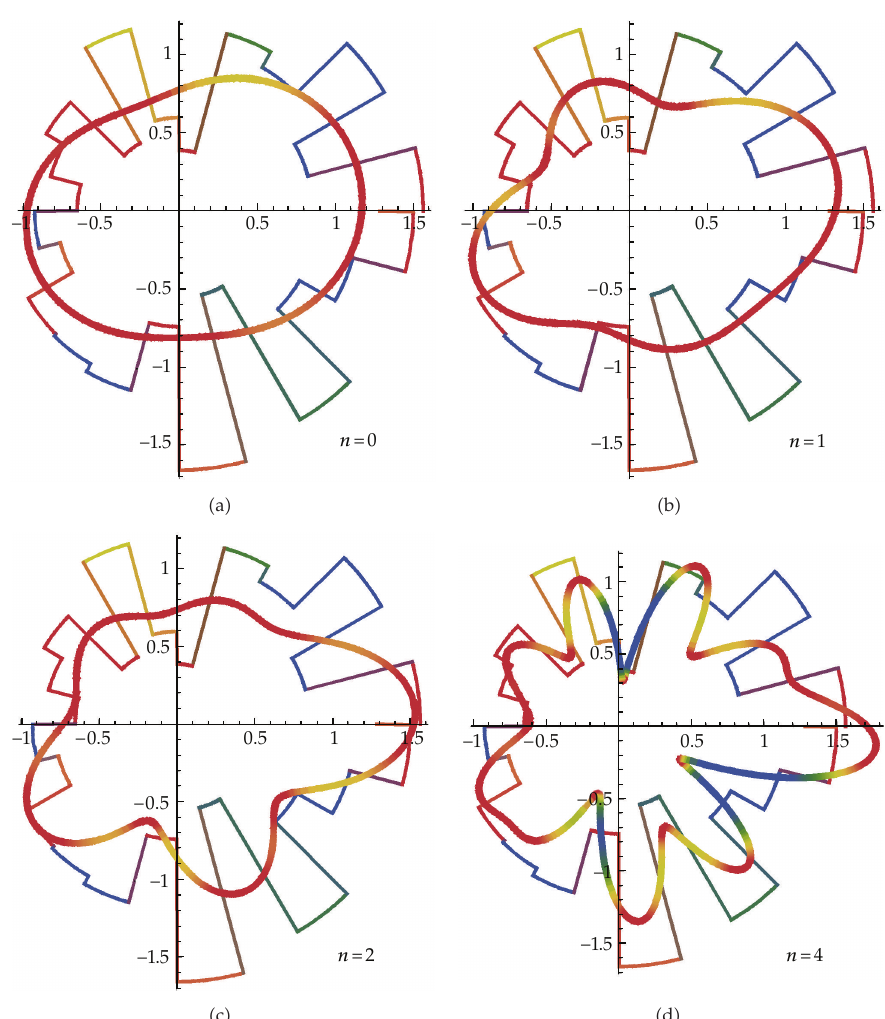
Figure 7: Original vector-valued ODF sampling from N (cid:3) 1 . 0 , 0 . 3 2 (cid:4) and its approximate ODFs using symmetric characterization in